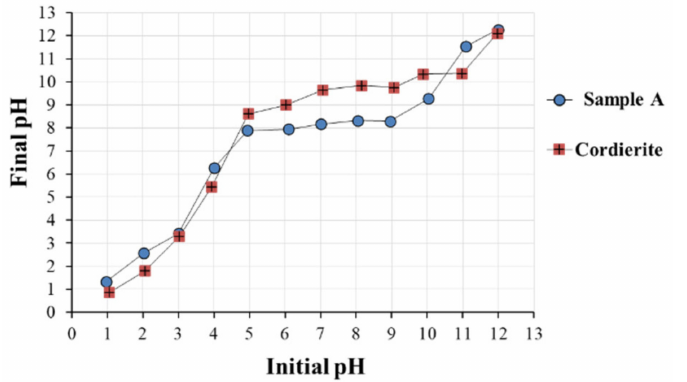
Figure 6. PZC measurements performed on cordierite and the standard Ni/boehmite sol (sample